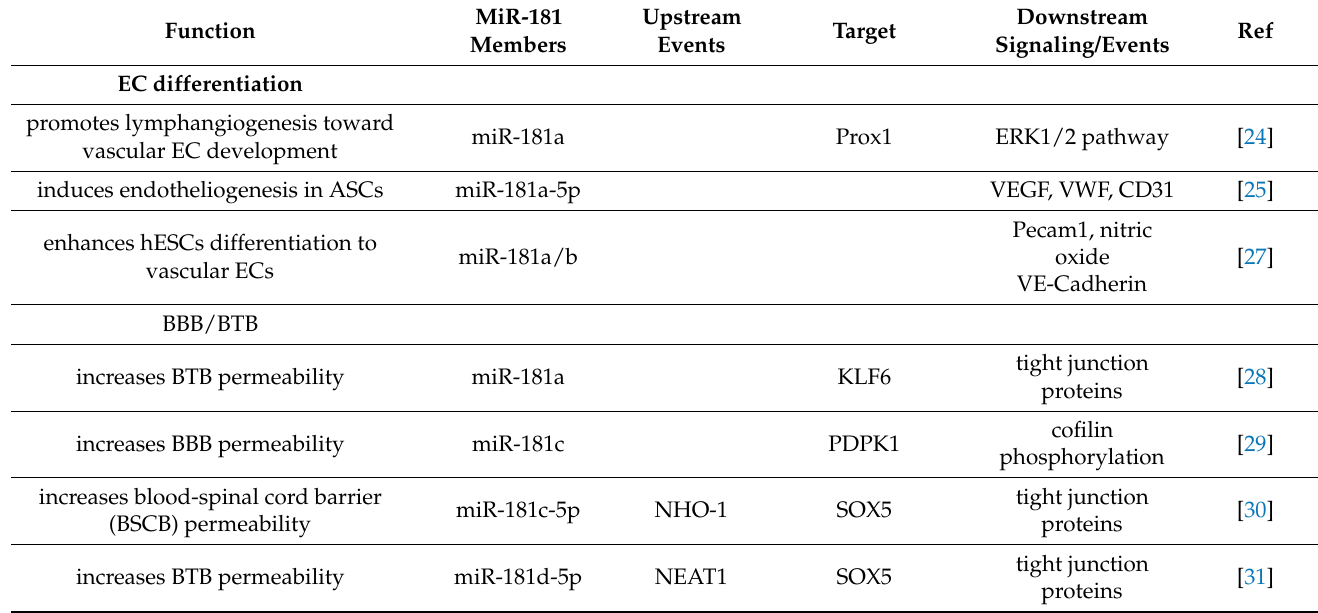
Table 1. Roles of miR-181 family members in EC differentiation and EC barrier